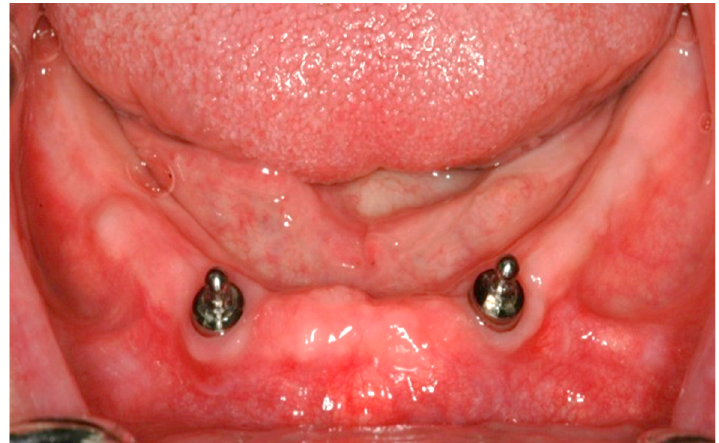
Figure 1. Two ball attachments connected to supporting implants